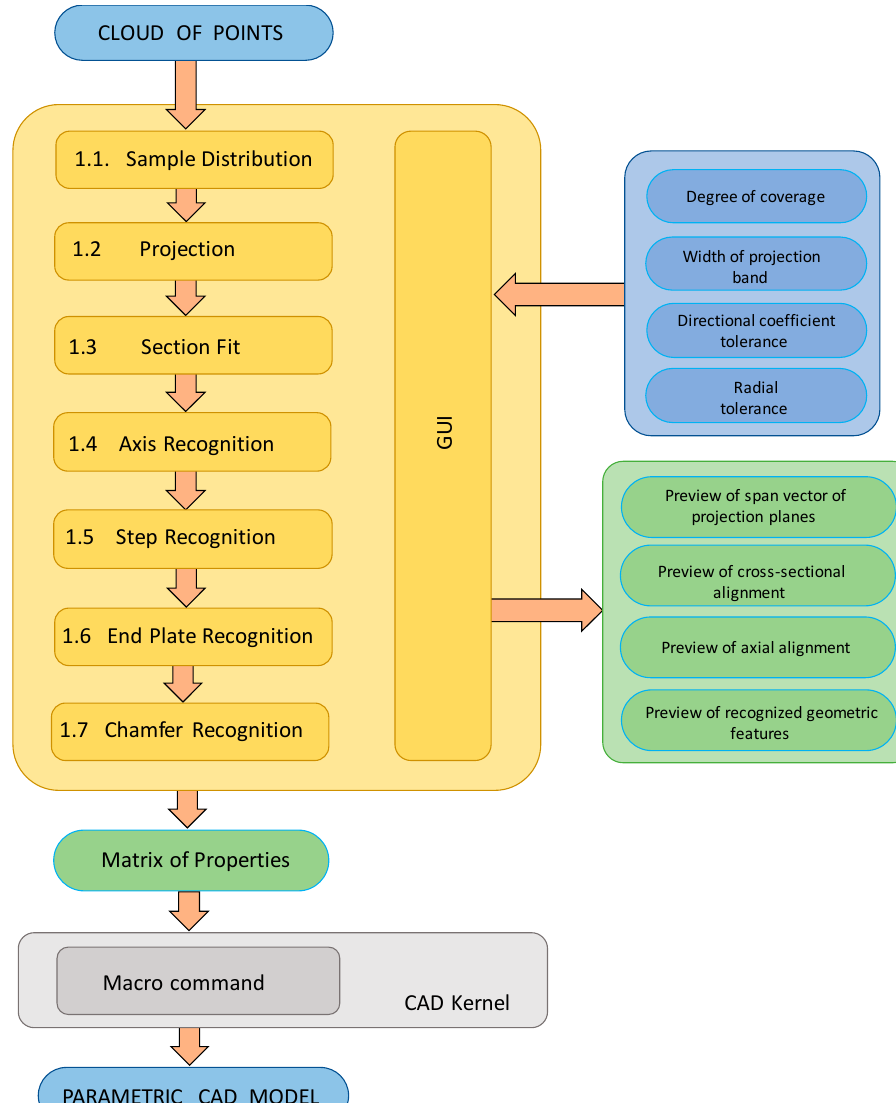
Figure 4. Diagram of cloud of points conversion to parametric geometry.